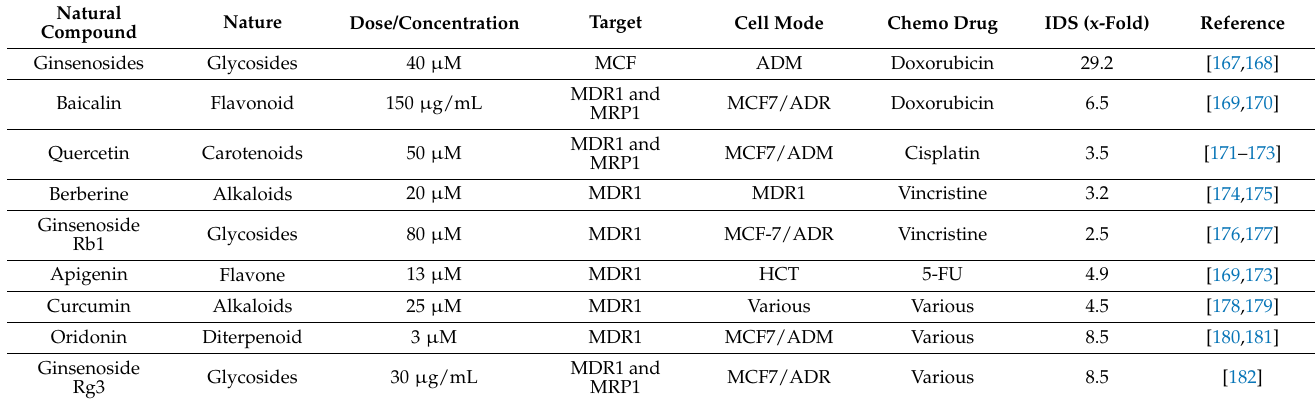
Table 3. The natural compounds that overcome drug resistance in